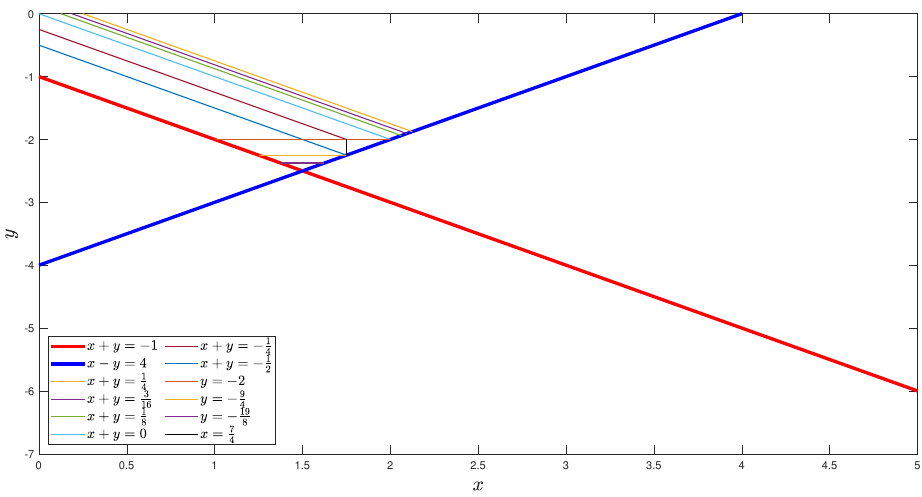
Figure 2. Regions considered in the proof of Case